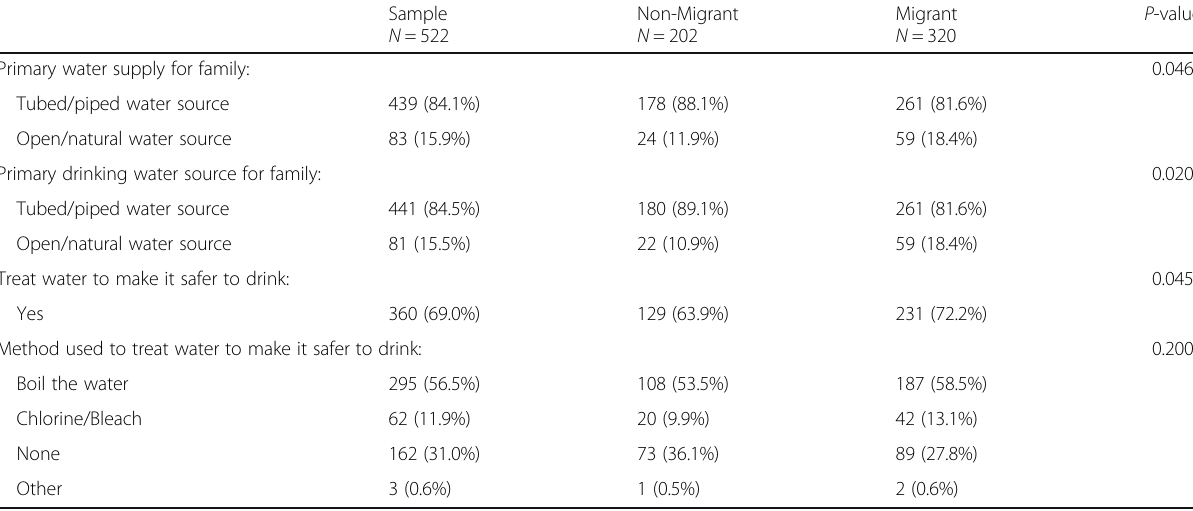
Table 3 Physical capital: Water access